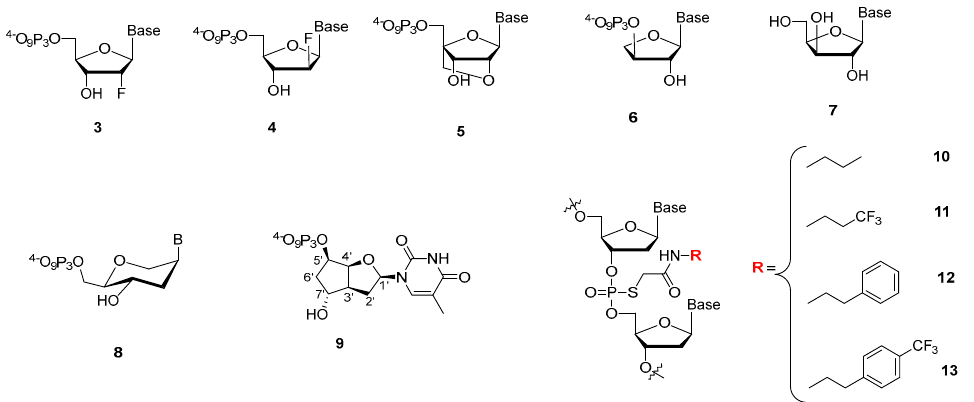
Figure 9. Chemical structures of sugar and phosphate modified nucleotides.